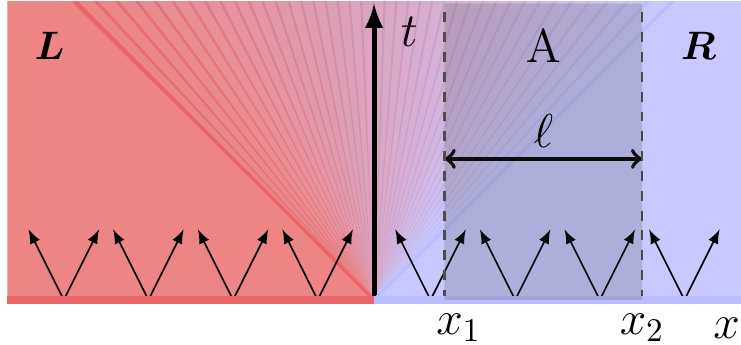
Figure 1: Sketch of the physical setting used in this work. At large times after the sudden junction of two macroscopically different states (left and right leads), local properties at fixed x / t are described by a Local Quasi Stationary State (LQSS). Here x is measured from the interface between the two chains. In this setting we are interested in the entanglement entropy of a region A of length (cid:96) . A semiclassical description in terms of free quasiparticles applies to the entanglement entropy. In the quasiparticle picture pairs of entangled quasiparticles are created in the bulk of the two chains. Quasiparticles forming an entangled pair have rapidity of opposite sign and initially travel with opposite